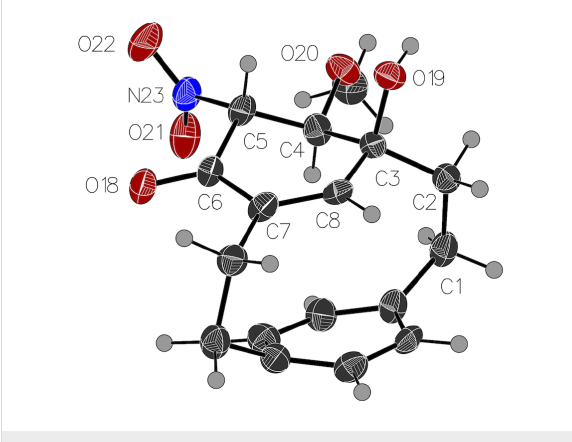
Figure 4: Crystal structure of 14 . Ellipsoids are drawn at a 50% proba- bility level [63].